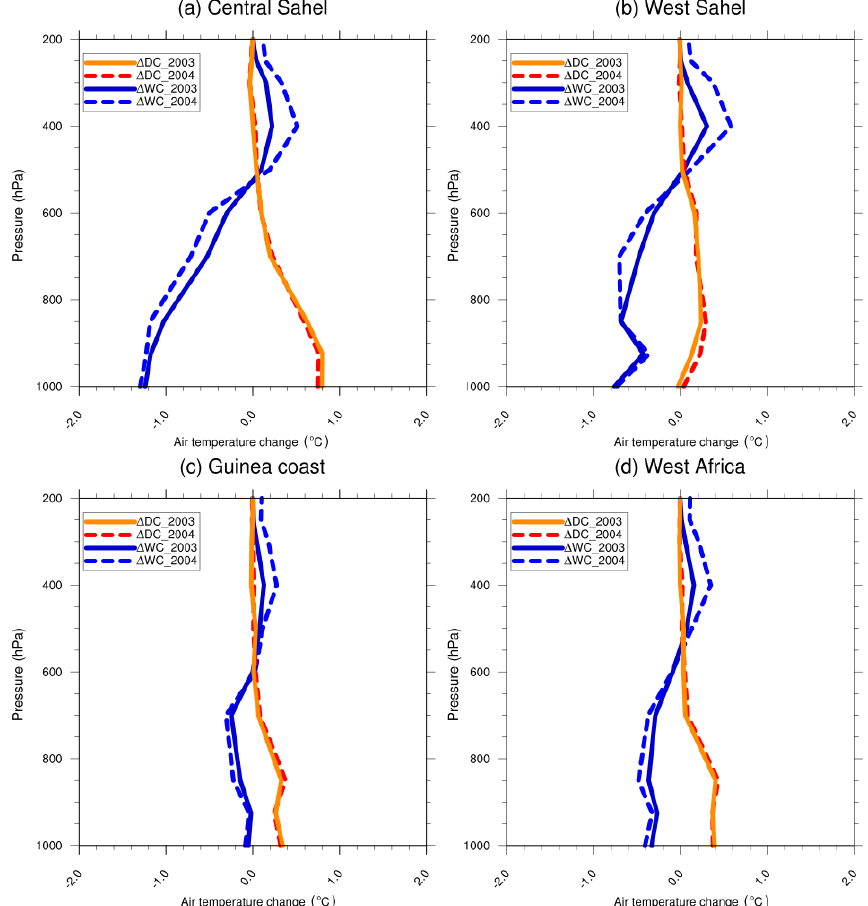
Figure 9. Vertical profile changes in temperature for JJAS 2003 and JJAS 2004 from the dry ( (cid:49) DC) and wet ( (cid:49) WC) experiments with respect to the control experiment over the (a) Central Sahel, (b) West Sahel, (c) Guinea coast and (d) West